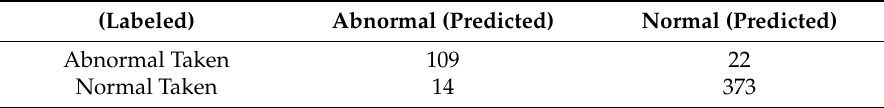
Table 2. Confusion matrix for validity classification.